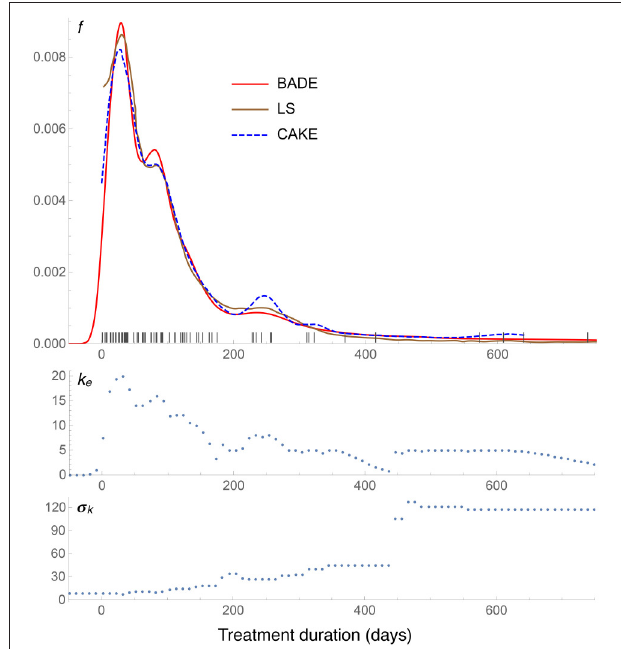
FIGURE 6 | Density estimates for the univariate Old Faithful data set, comparing our method (BADE) with LS ( Brewer, 2000), CAKE (Ganti and Gray, 2011), and VB3 (Hazelton, 2003). The second and third rows show, respectively, the optimal effective number of nearest neighbors, and the standard deviation of the set of the k nearest neighbors, at each point of a regular grid of size 100. The marks on the x axis indicate the sample points.